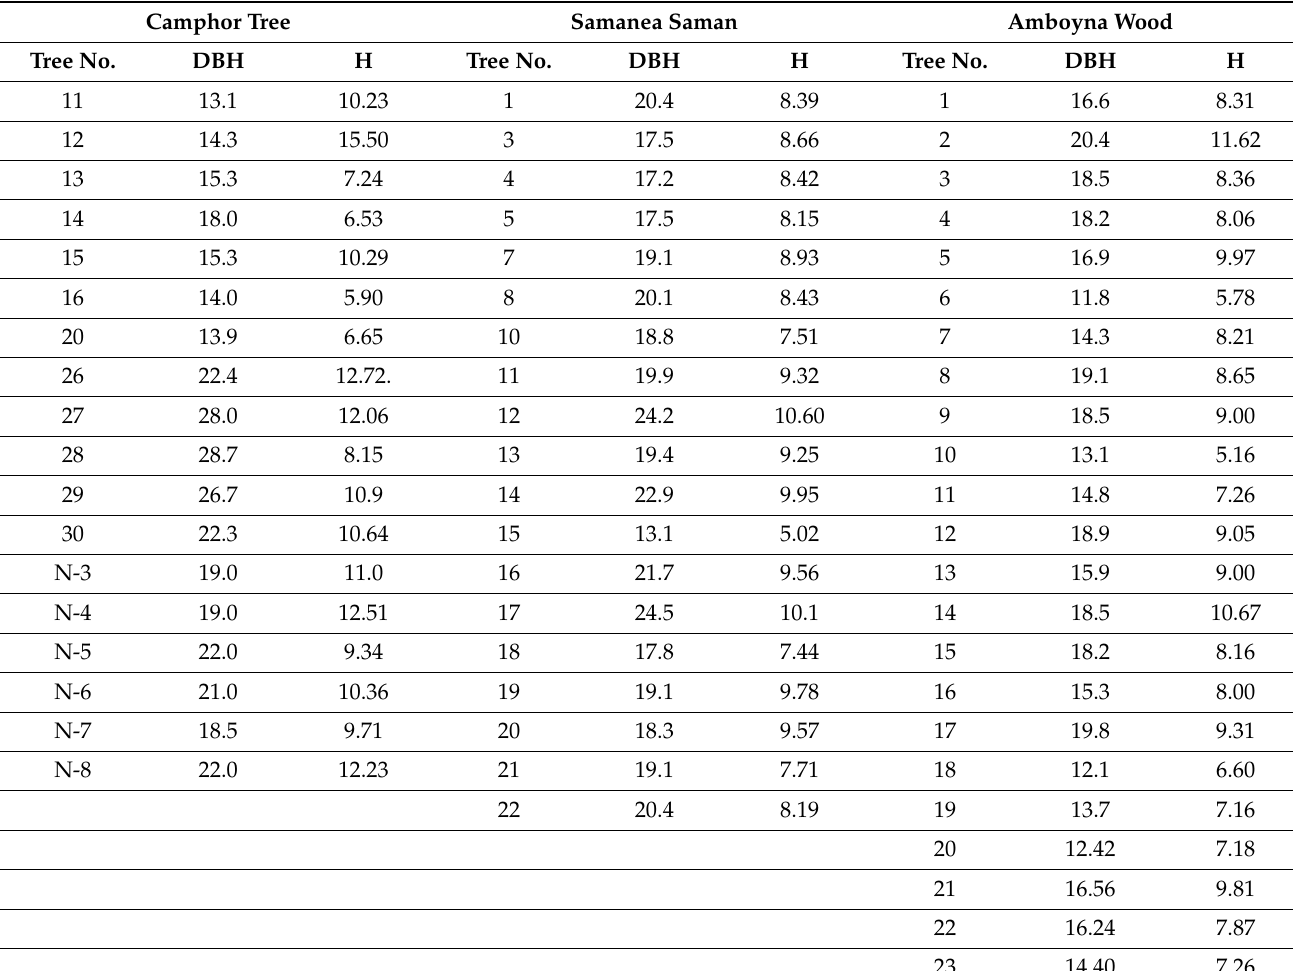
Table 2. Geometry of the trees used in the experiment. Camphor